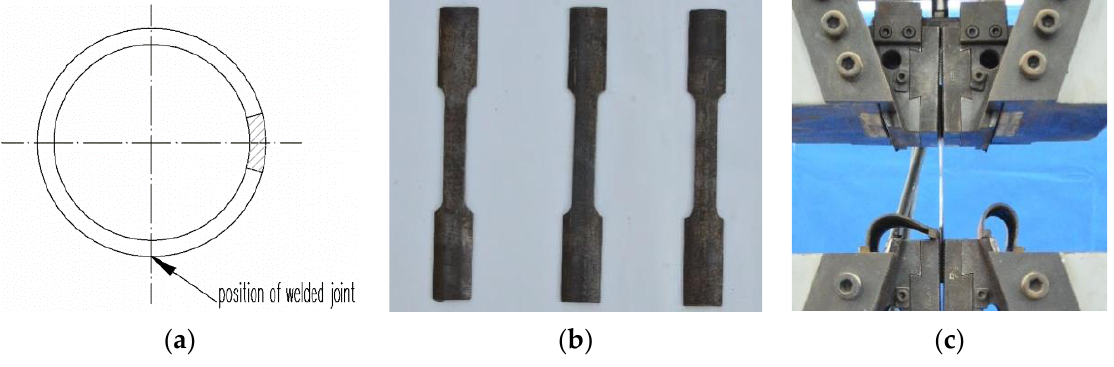
Figure 6. Steel pipe material sample. ( a ) Sampling location; ( b ) Tensile specimen; ( c ) Material test. Table 2. Mechanical performance test results of steel pipes.